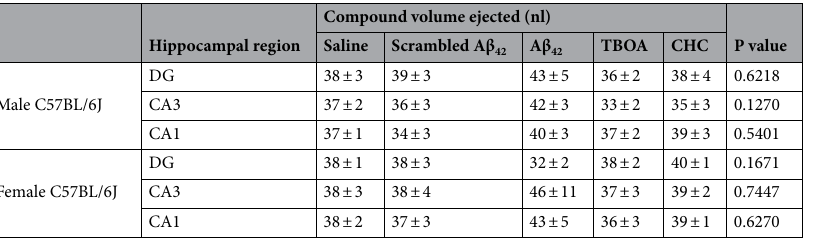
Table 1. Average pressure ejected volumes. Volumes are shown in mean ± SEM for application of each compound for all brain regions and sexes along with the corresponding P value from a one-way ANOVA.